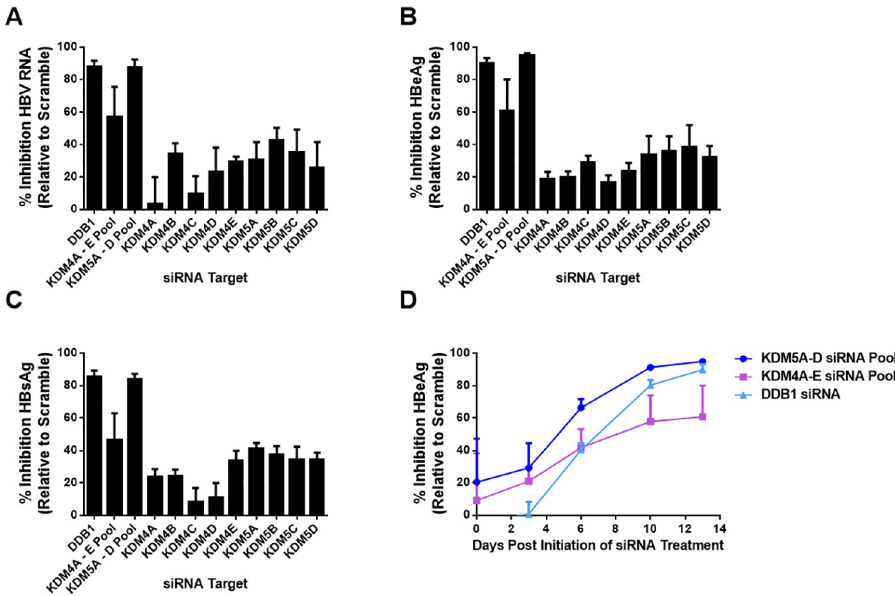
Fig 2. Knockdown of KDM5 confers antiviral activity in PHH. KDM4 and KDM5 transcripts were depleted by siRNA either individually ( KDM4A , B , C , D , or E ; KDM5A , B , C , or D ) or simultaneously ( KDM4A – E pool; KDM5A – D pool) in HBV-infected PHH. DDB1 , the well-characterized HBV host restriction factor, was also depleted by siRNA for comparison. Fourteen days after initiation of siRNA transfection, levels of (A) intracellular HBV RNA, (B) secreted HBeAg, and (C) secreted HBsAg were measured by qRT-PCR or immunoassay, respectively, for each siRNA condition. (D) The kinetics of HBeAg inhibition is shown for KDM4A – E pool, KDM5A – D pool, and DDB1 siRNA conditions. Data shown are the average of two biological replicate experiments and error bars represent the standard deviation.